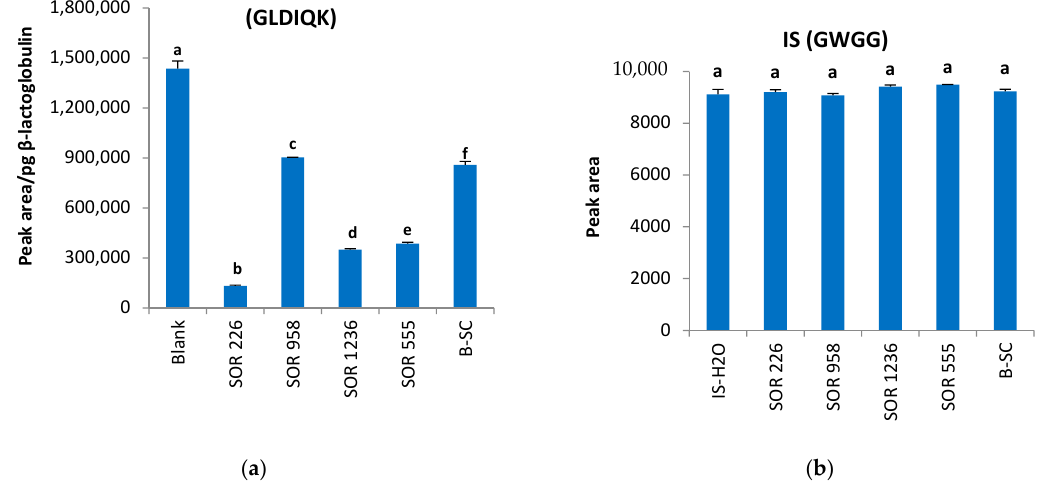
Figure 3 Effects of the matrix of sorghum cultivars SOR 226, 958, 1236, 555 and B.Sc on ( a ) β -lactoglobulin and ( b ) internal standard. Data are expressed as means ± standard deviation, n = 3. Different letters indicate significantly different values ( p < 0.05).